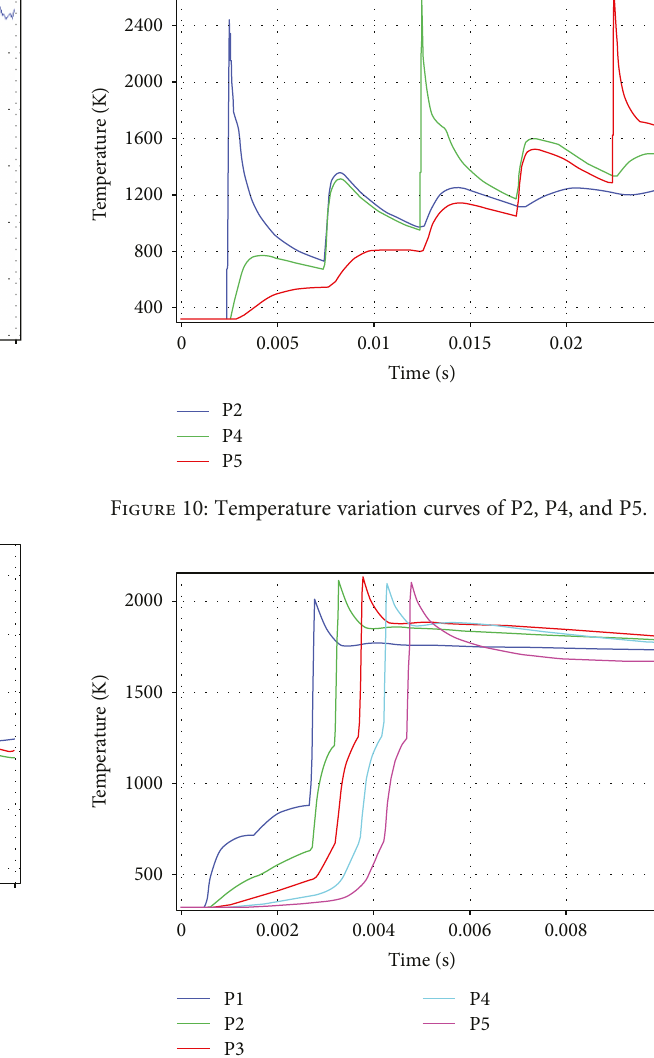
Figure 11: Temperature variations with time at points P1 to P5 under the island scanning